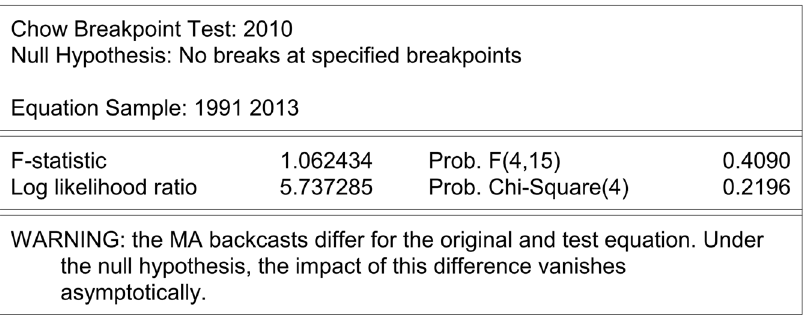
Figure 2. The result of chow breakpoint